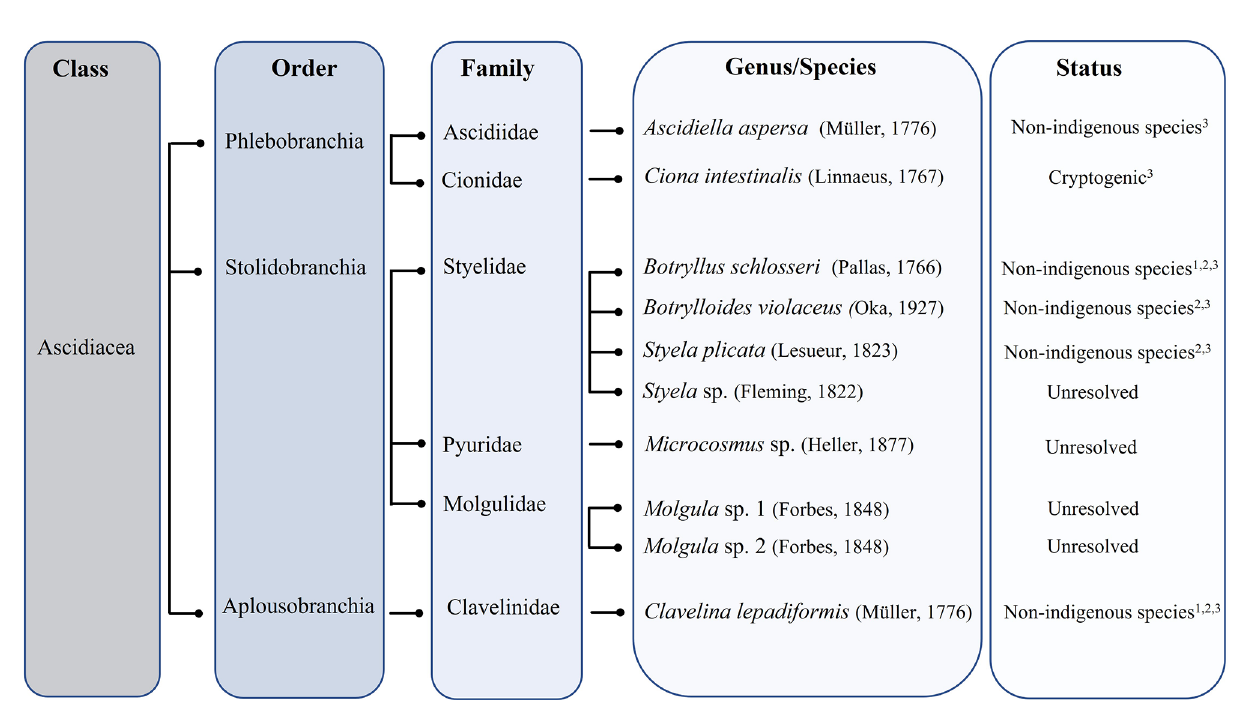
FIGURE 3 | Taxonomic tree of the ten identi fi ed species retrieved from the Ria de Aveiro. Superscript numbers indicate reference: 1- Canning-Clode et al. (2013); 2 – Chainho et al. (2015); 3 – Ramalhosa et al.